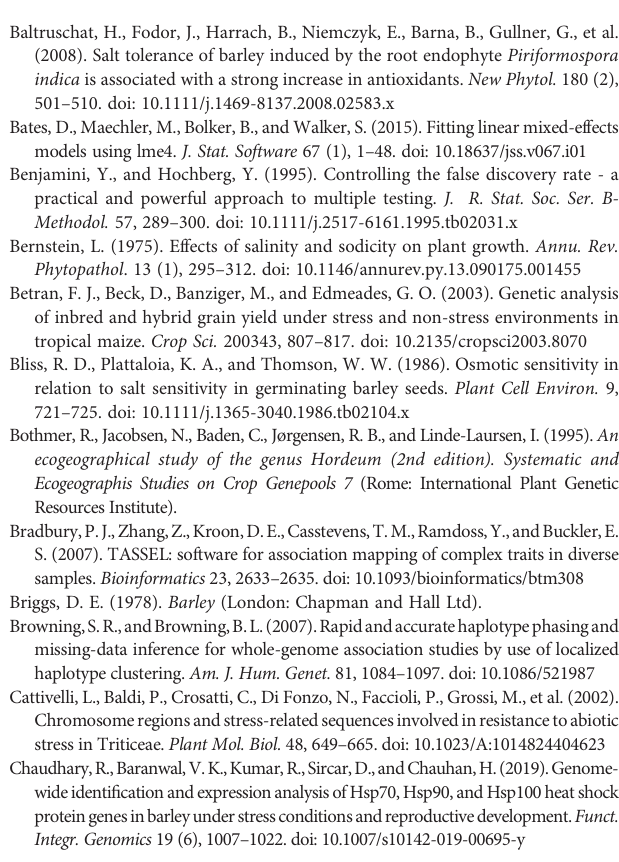
SUPPLEMENTARY FIGURE 1 | A map showing geographical representation and origin of barley accessions used in this study. SUPPLEMENTARY FIGURE 2 | Annual average weather pattern for Merredin and Katanning as reported by the Australian Bureau of Meteorology (http://www. bom.gov.au/index.php). SUPPLEMENTARY FIGURE 3 | Correlation coef fi cient for germination in 150 mM NaCl against tolerance index for seeds from Merredin and Katanning. SUPPLEMENTARY FIGURE 4 | Estimate of the most probable number of clusters (k) and population structure. SUPPLEMENTARY FIGURE 5 | Average germination percent distribution of 350 barley accession in deionized